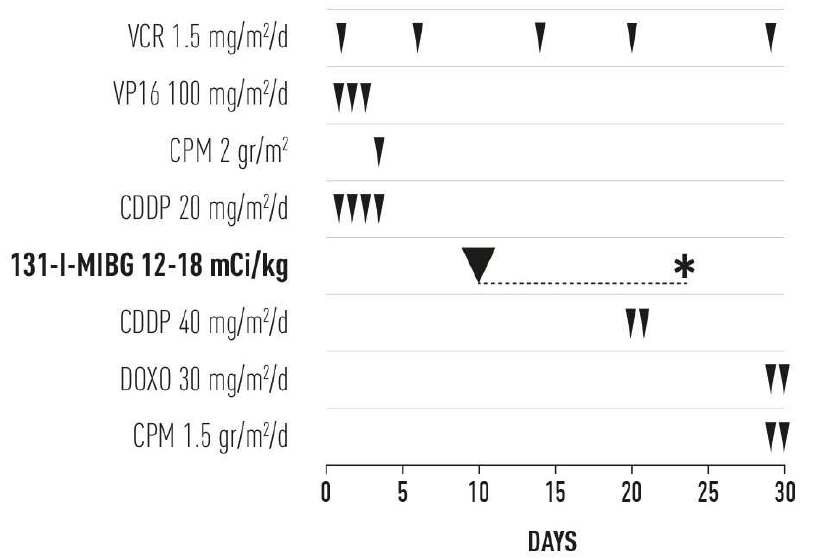
Figure 1. Treatment schema. VCR = vincristine, VP16 = etoposide, CPM = cyclophosphamide, CDDP = cisplatin, 131-I-MIBG = 131-I-metaiodobenzylguanidine, DOXO = doxorubicin. * Low-dose rate form of irradiation after 131-I-MIBG administration and protracted for about 2 weeks.